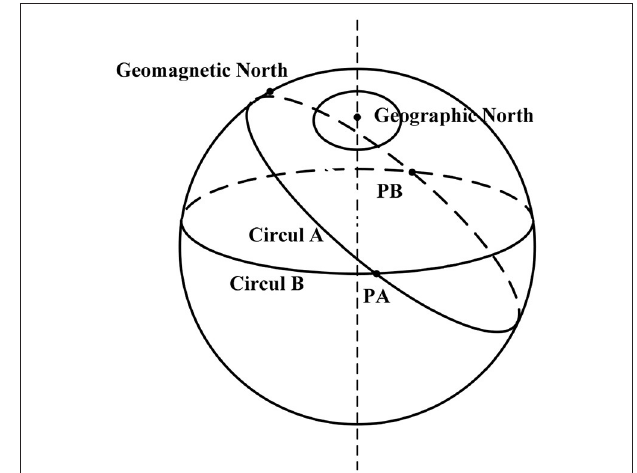
FIGURE 1 | The vectors of the geomagnetic fields.